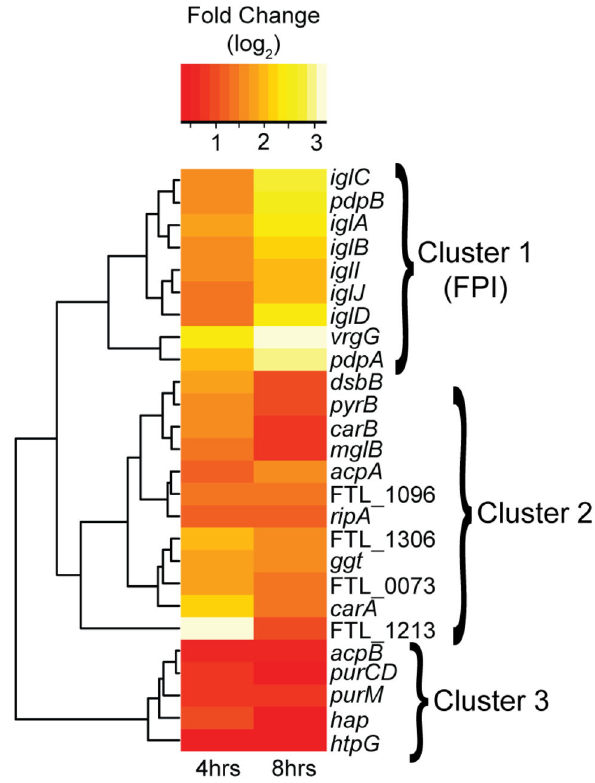
Figure 4. Heat map of virulence factor genes up- and down-regulated at each time point. Change in expression was determined for previously identified F . tularensis virulence factor genes at both post-infection time points, and then clustered to identify genes that are coordinately regulated. The cluster analysis segregated the genes into three groups. Cluster 1, in which the genes are up-regulated at both post- infection time points, is comprised entirely of genes in the FPI. doi: